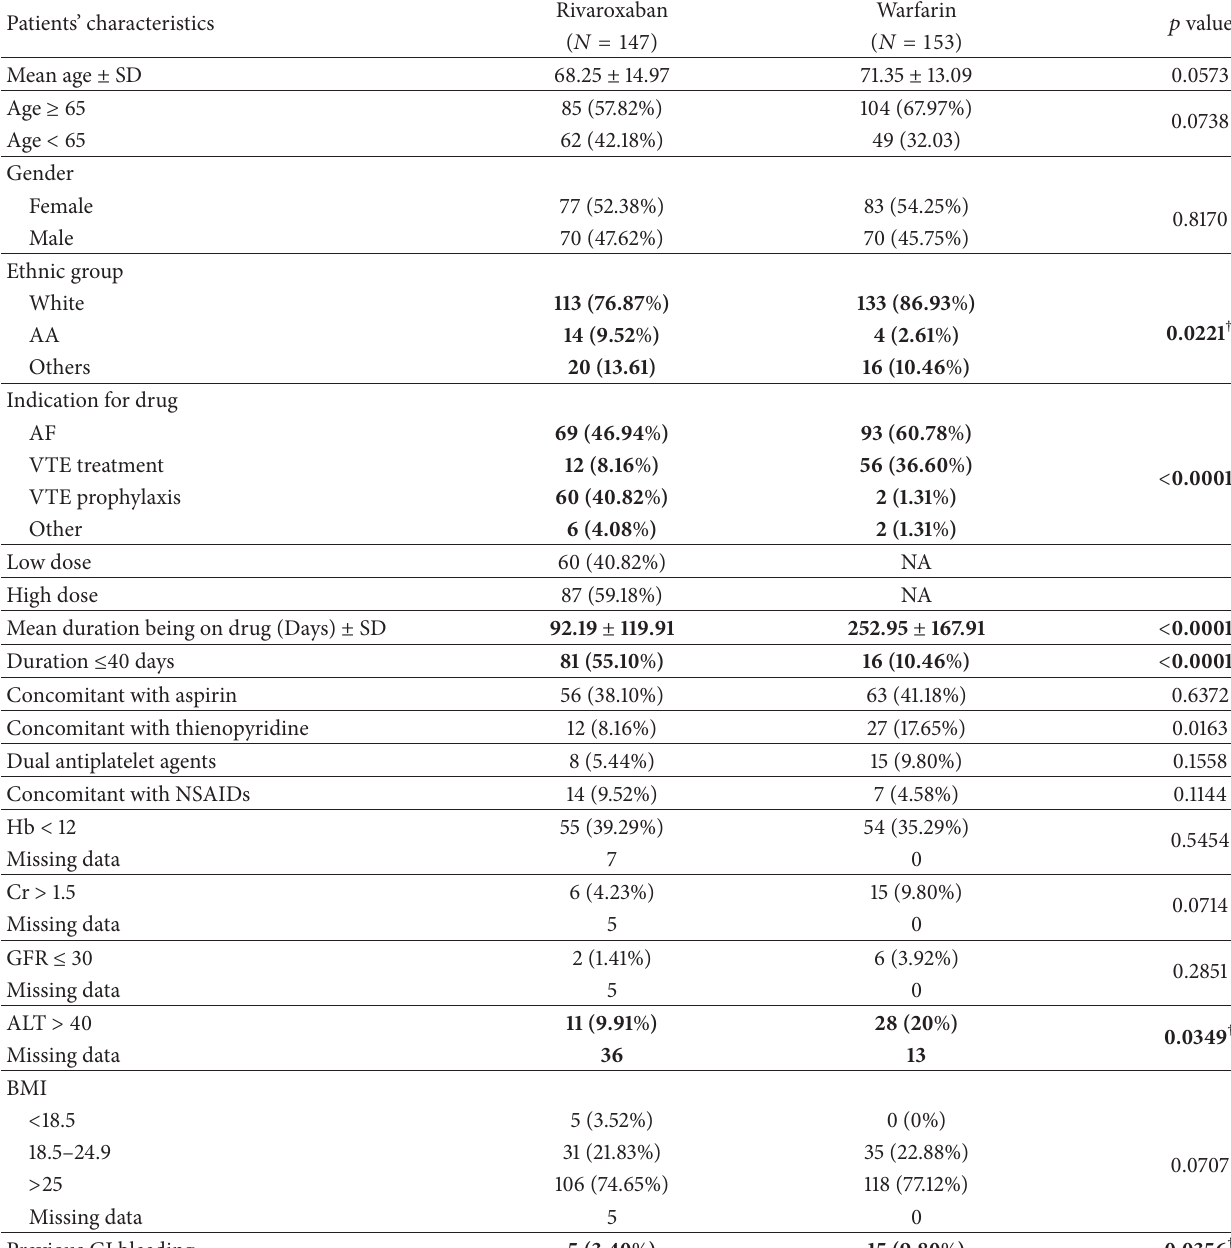
Table 1: Demographic and clinical characteristics of patients in both